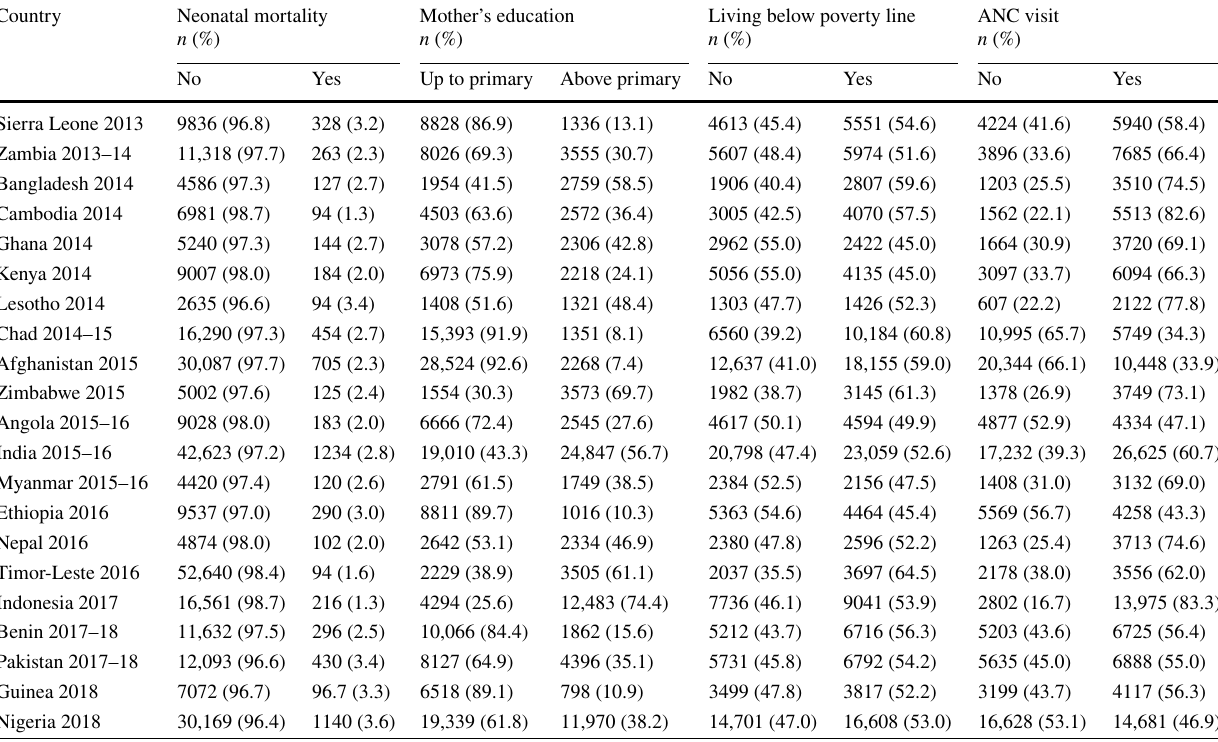
Table 1 Frequency and percentage of selected factors from 21 developing countries